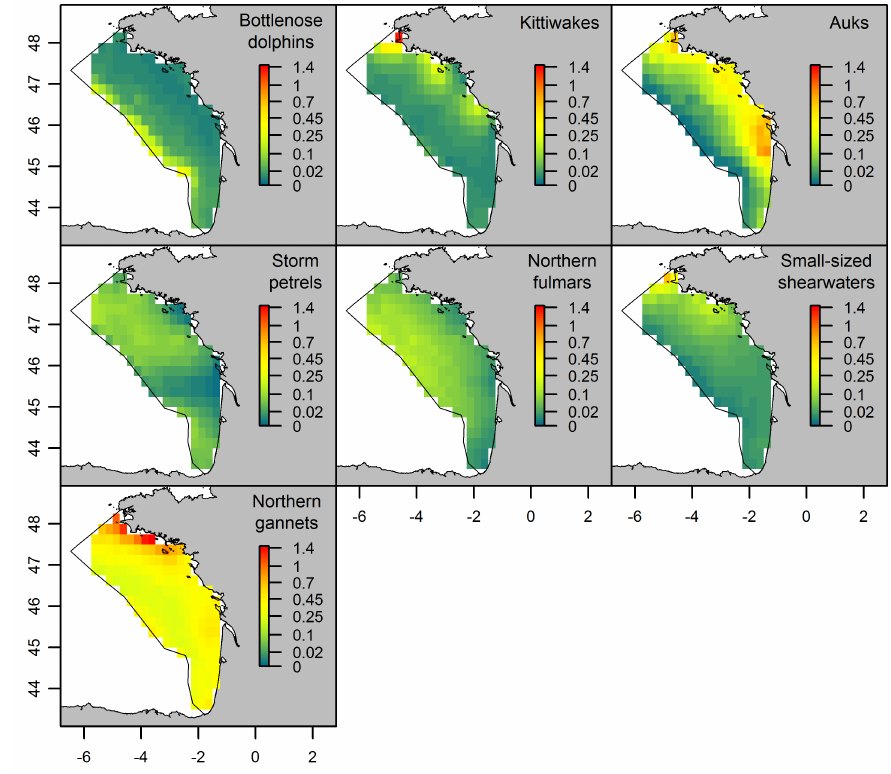
Figure 2 – Predicted densities (individual/km 2 ) averaged over the fourteen studied years for the seven studied